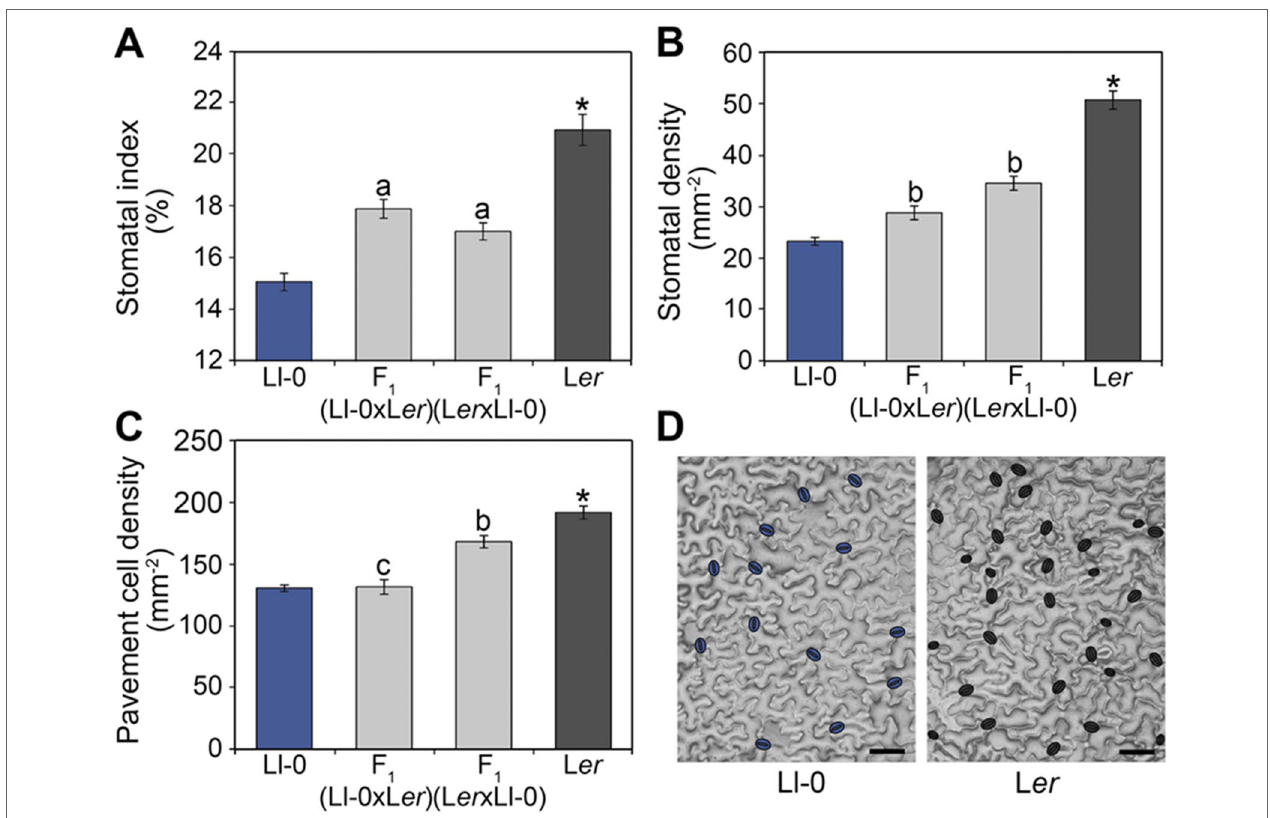
FIGURe 1 | Stomatal abundance traits in Ll-0, L er , and their reciprocal hybrids. Adaxial cotyledon epidermis was scored at maturity (21 dag) for stomatal index (A) and density (B) and for pavement cell density (C) . Bars represent mean ± SE of 10 plants. Phenotypic differences were analyzed using a Tukey's test. Significant differences between Ll-0 and L er are indicated with an asterisk. Letters over bars refer to phenotypic comparisons of each F 1 hybrid with the remaining genotypes: "a" indicates significant differences from both parents; "b" indicates differences from all other genotypes; "c" indicates differences from male parent and reciprocal hybrid. (D) Representative mature adaxial cotyledon epidermis of Ll-0 and L er , with stomata false-colored in blue. Micrographs were obtained with the dental resin method. Scale bars are 100